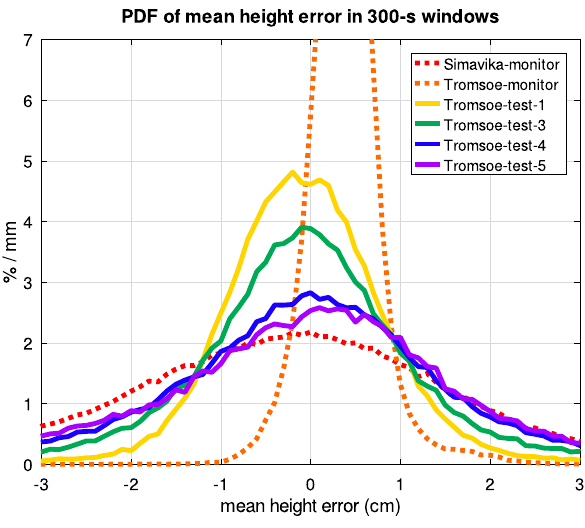
Fig. 9 Probability density function of vertical position error, using the entire dataset for each